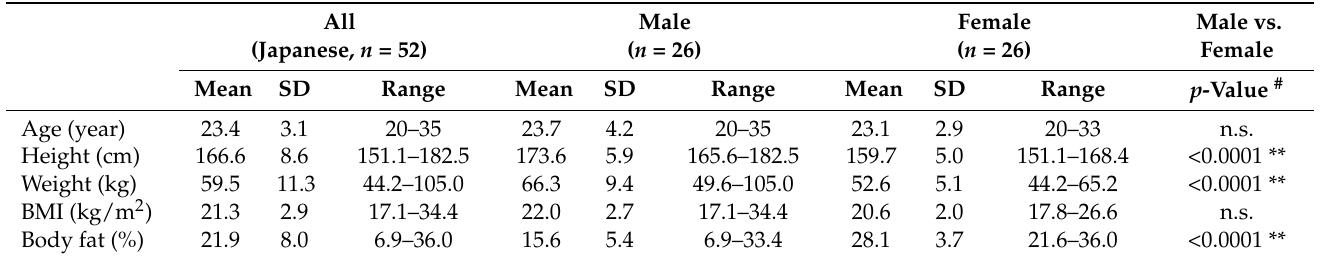
Table 1. General characteristics of the